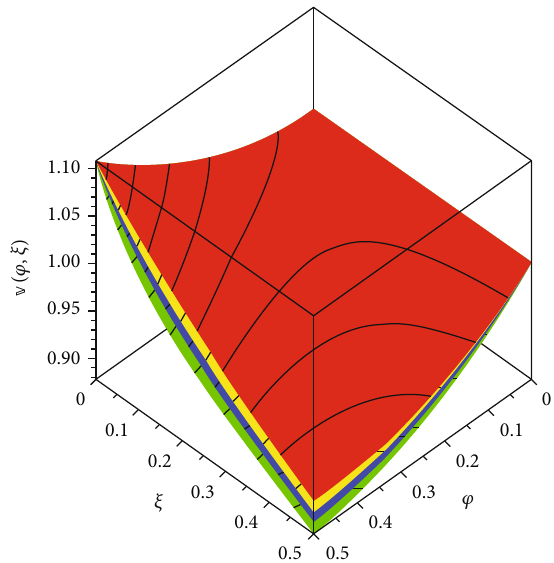
Figure 3: The di ff erent fractional-order ℘ of Example